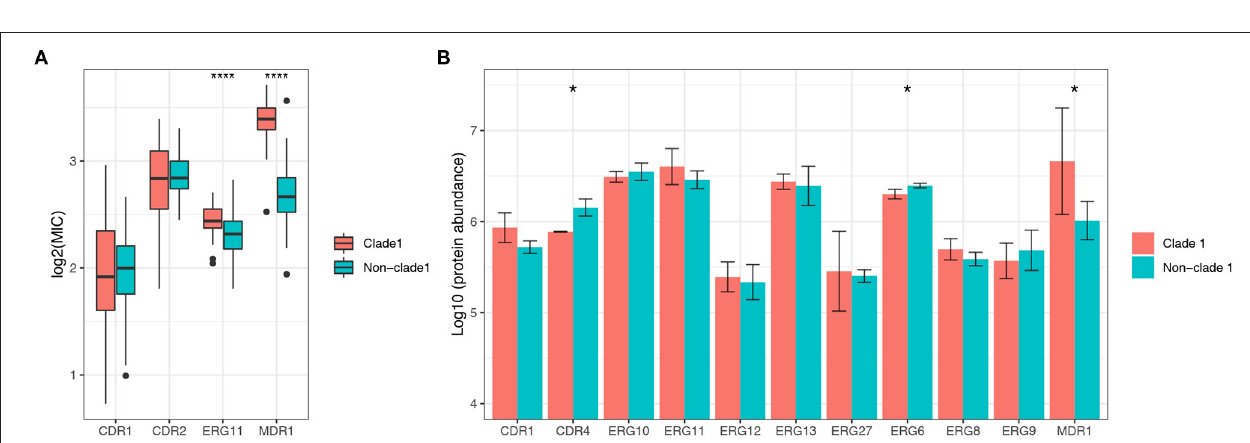
FIGURE 3 | The susceptibility of C. albicans isolates in MLST clade 1 to antifungal drugs was significantly lower than that of non-clade 1 isolates. The MIC90 of each clade for 14 different antifungal drugs is presented (A) , revealing that the drug resistance of isolates from clade 1 was higher than that of other isolates. The Wilcoxon test was performed based on the MICs of each strain between clade 1 and non-clade 1 (B) . The resistance to all the antifungal drugs of the strains in clade 1 was significantly higher than that of non-clade 1 strains, except for resistance to MFG.